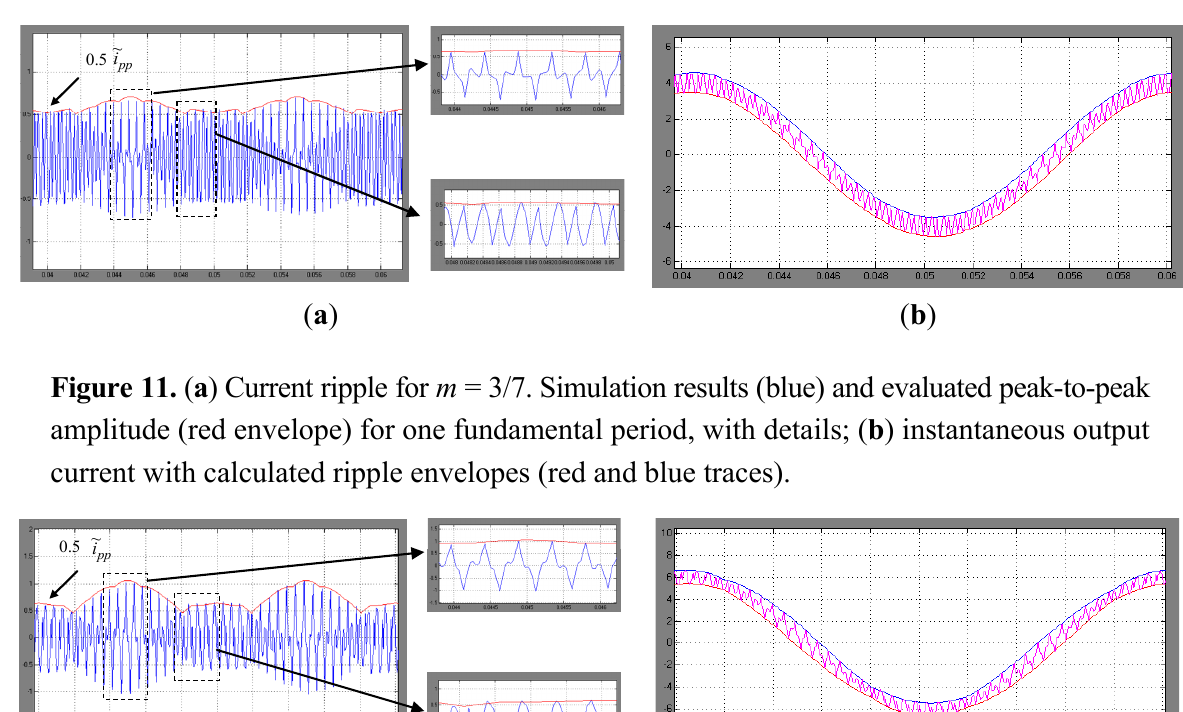
Figure 10. ( a ) Current ripple for m = 2/7. Simulation results (blue) and evaluated peak-to-peak amplitude (red envelope) for one fundamental period, with details; ( b ) instantaneous output current with calculated ripple envelopes (red and blue traces).